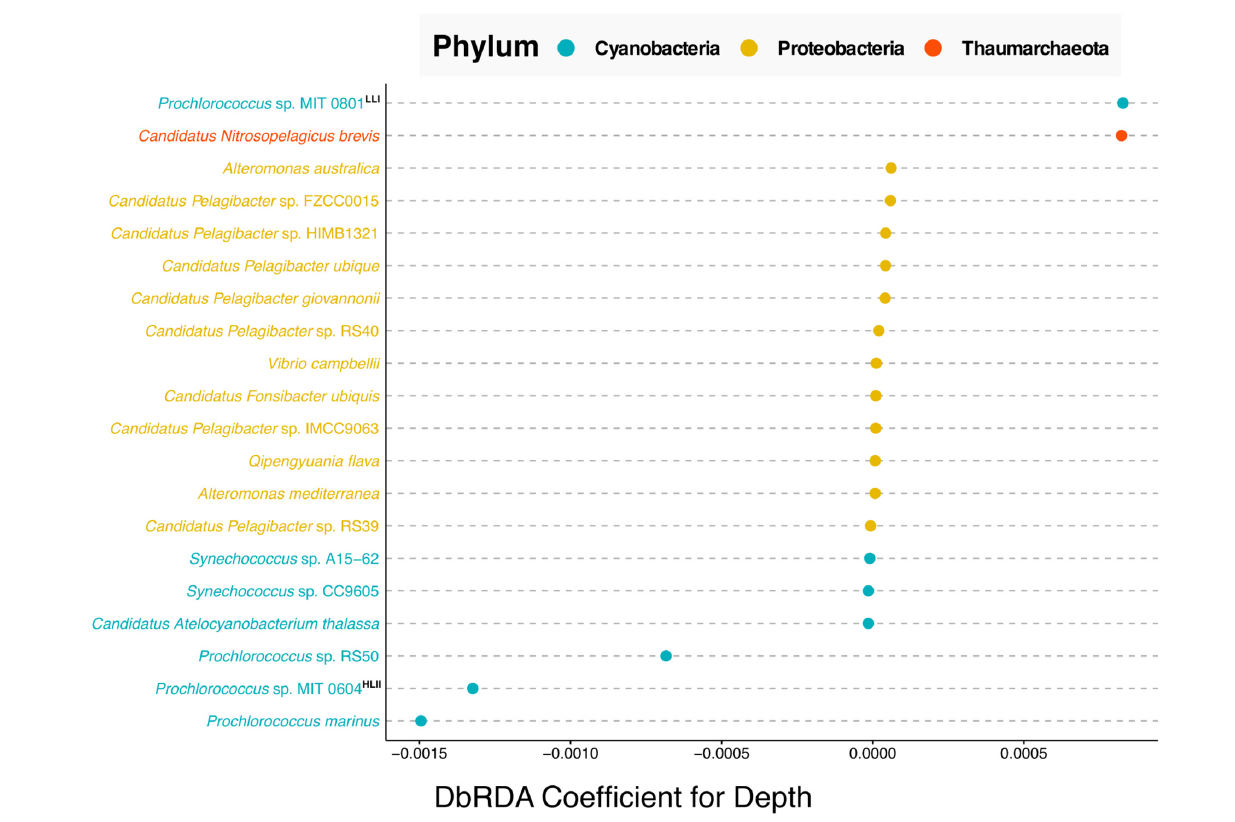
clade, which is congruent with our results showing MIT 0604 to be more abundant at shallower